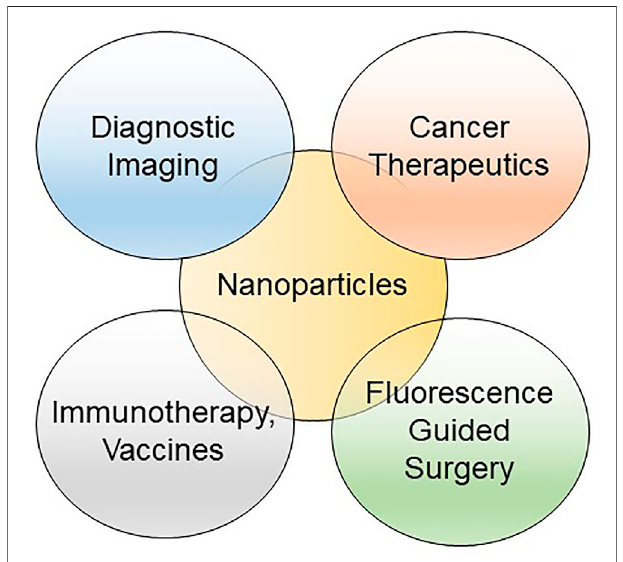
FIGURE 1 | Venn diagram of the applications for nanoparticles in translational